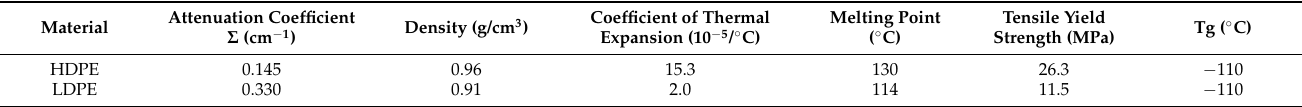
Table 5. HDPE and LDPE performance comparison